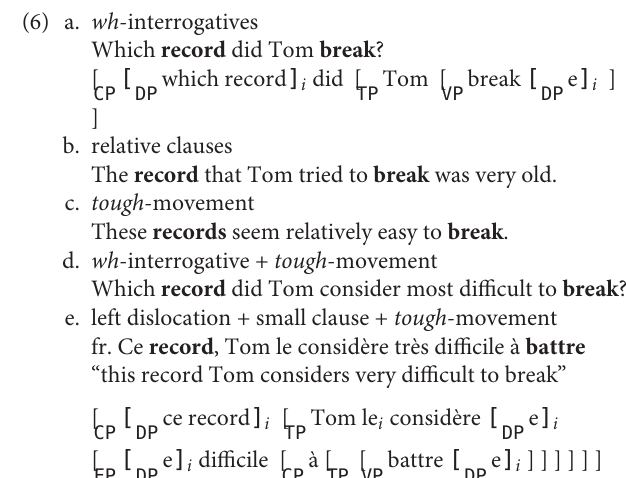
FIGURE 1 | Phrase-structure representation for sentence (Example